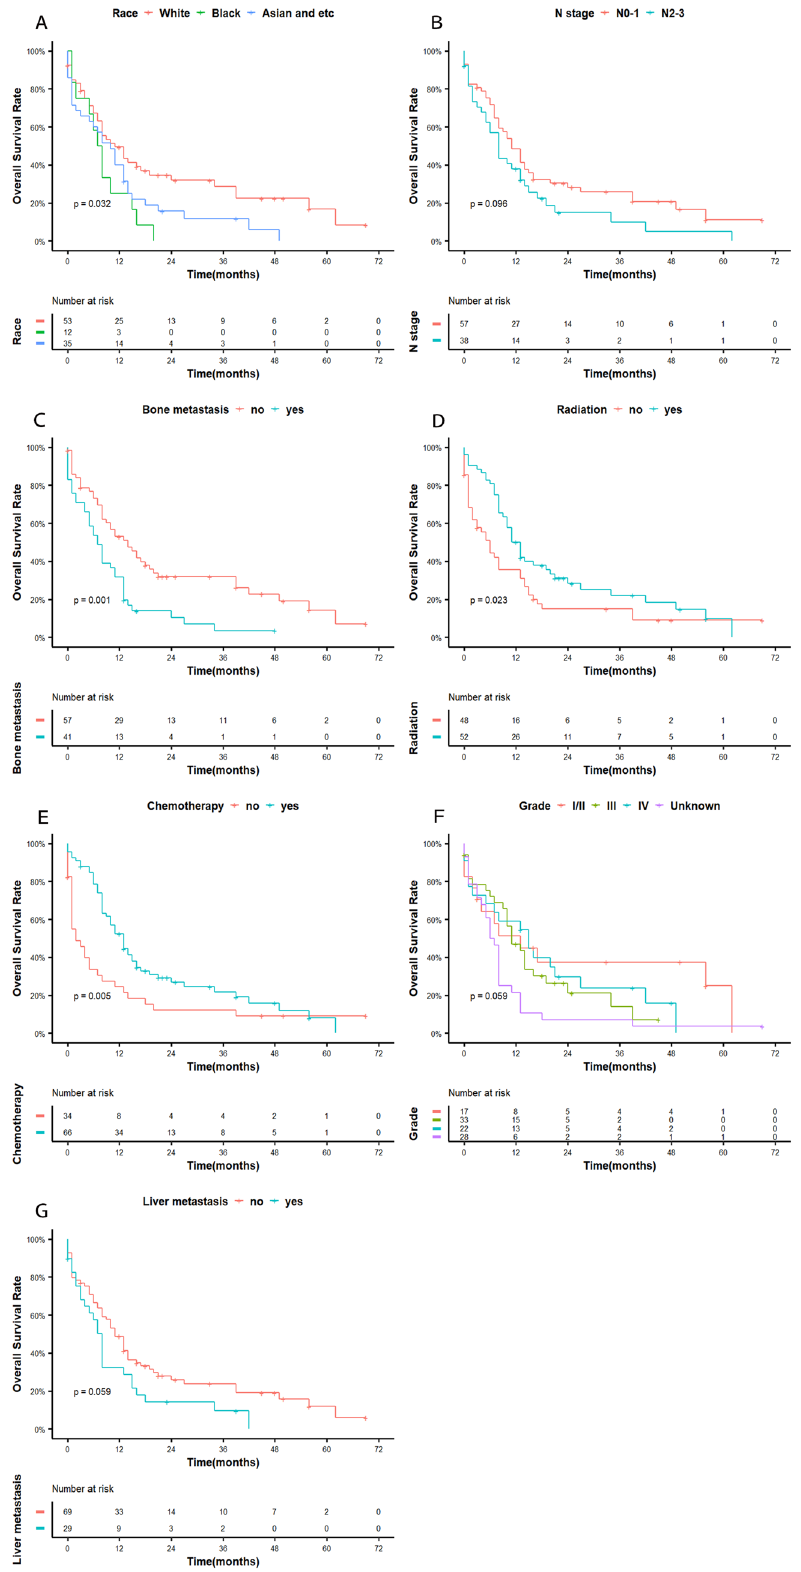
Figure 2. Kaplan–Meier curves showing ( A ) race, ( B ) N stage, ( C ) bone metastasis, ( D ) radiation, ( E ) chemotherapy, ( F ) grade, and ( G ) liver metastasis for